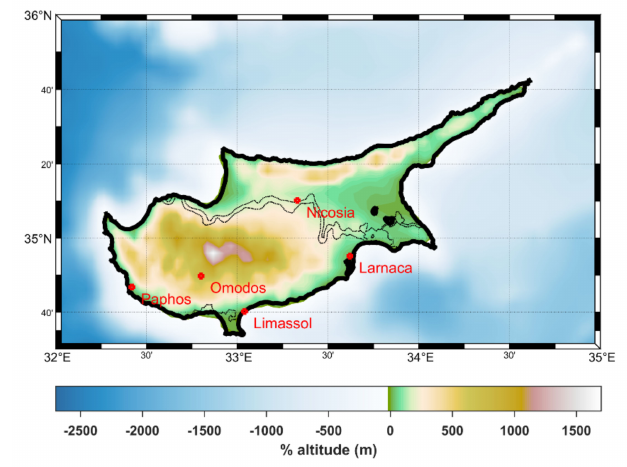
Figure 2. The five locations used for the